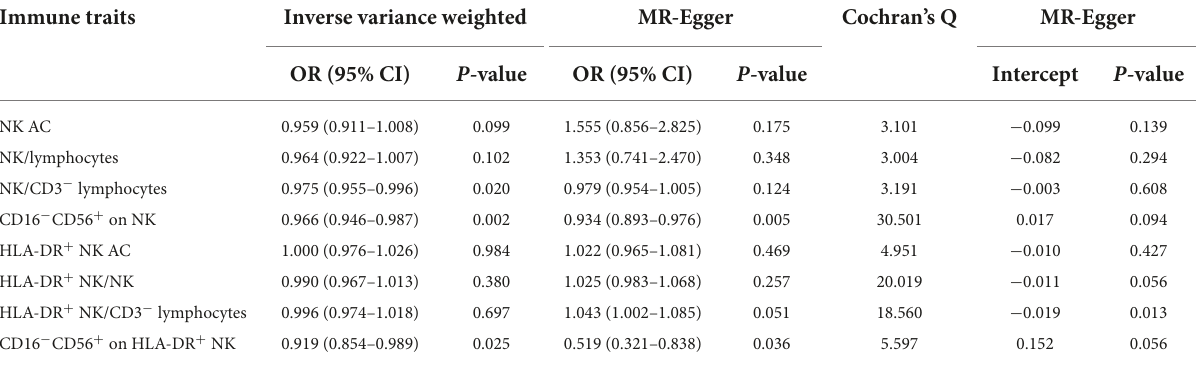
TABLE 1 Summary of the causal effects of natural killer (NK) cells-related immune traits on amyotrophic lateral sclerosis (ALS) with various Mendelian randomization (MR)